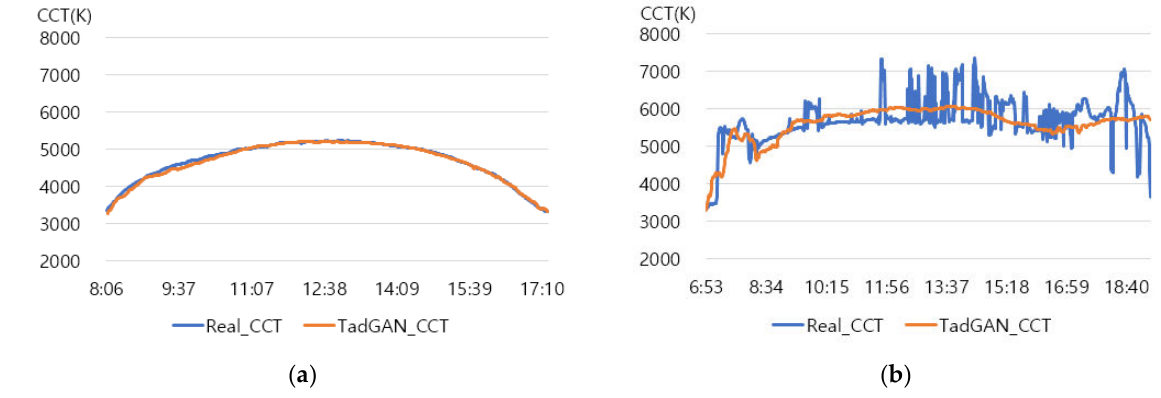
Figure 6. TadGAN-based color temperature cycle generation experiment. ( a ) Clear day: anomaly ratio less than 5%; ( b ) Cloudy day: anomaly ratio more than 30%.